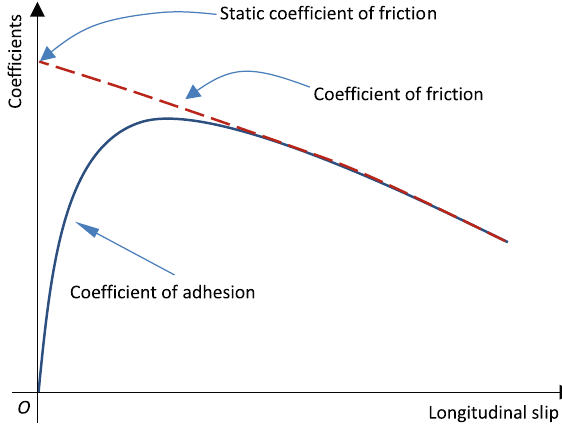
Fig. 7 Illustrations of coefficient of friction and coefficient of